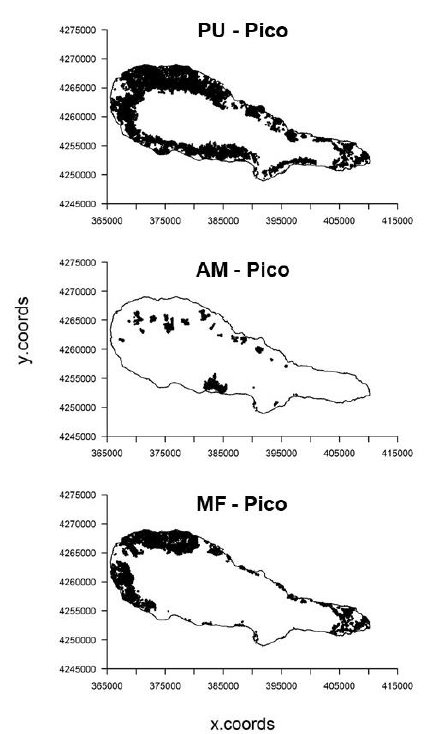
Figure 1. Species distribution data for P. undulatum (PU), A. melanoxylon (AM), and M. faya (MF) in Pico Island.